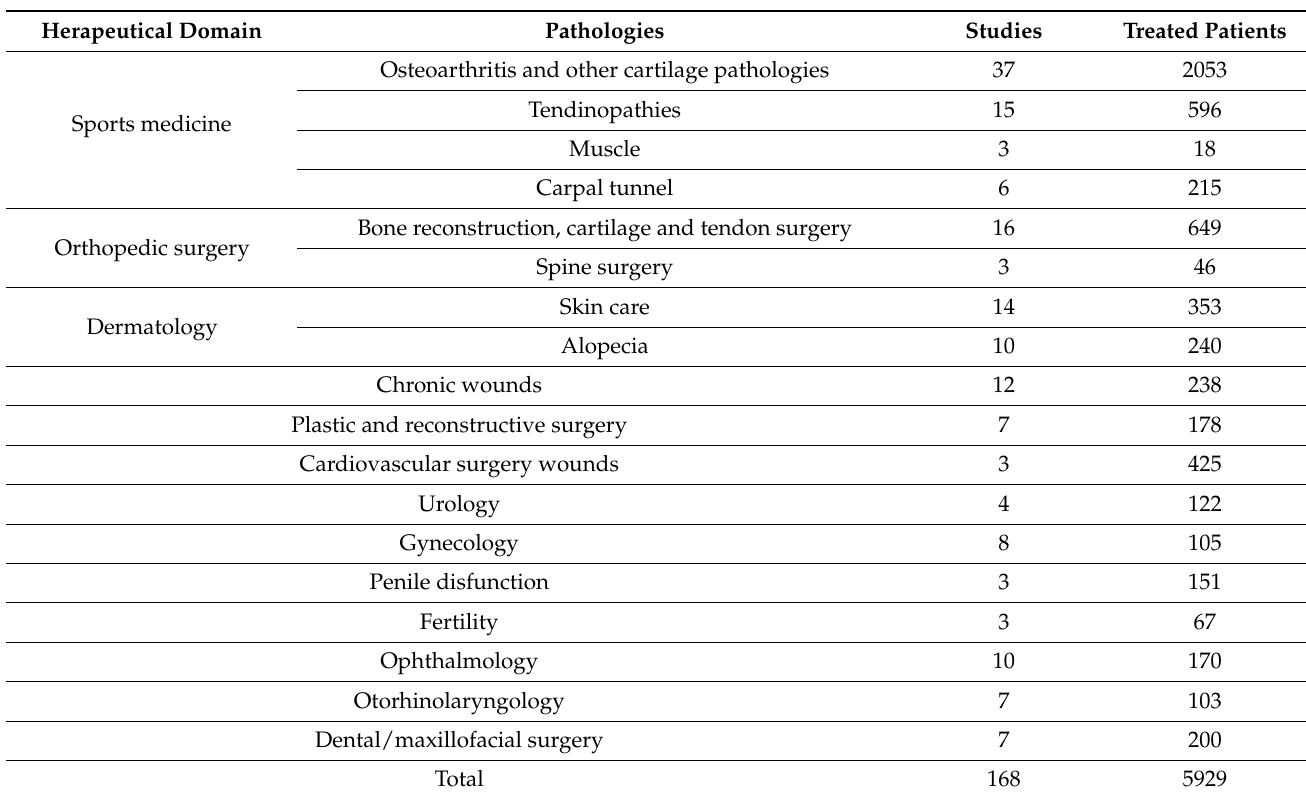
Table 2. Published clinical studies in which biologics manufactured with Regen Lab devices were successfully